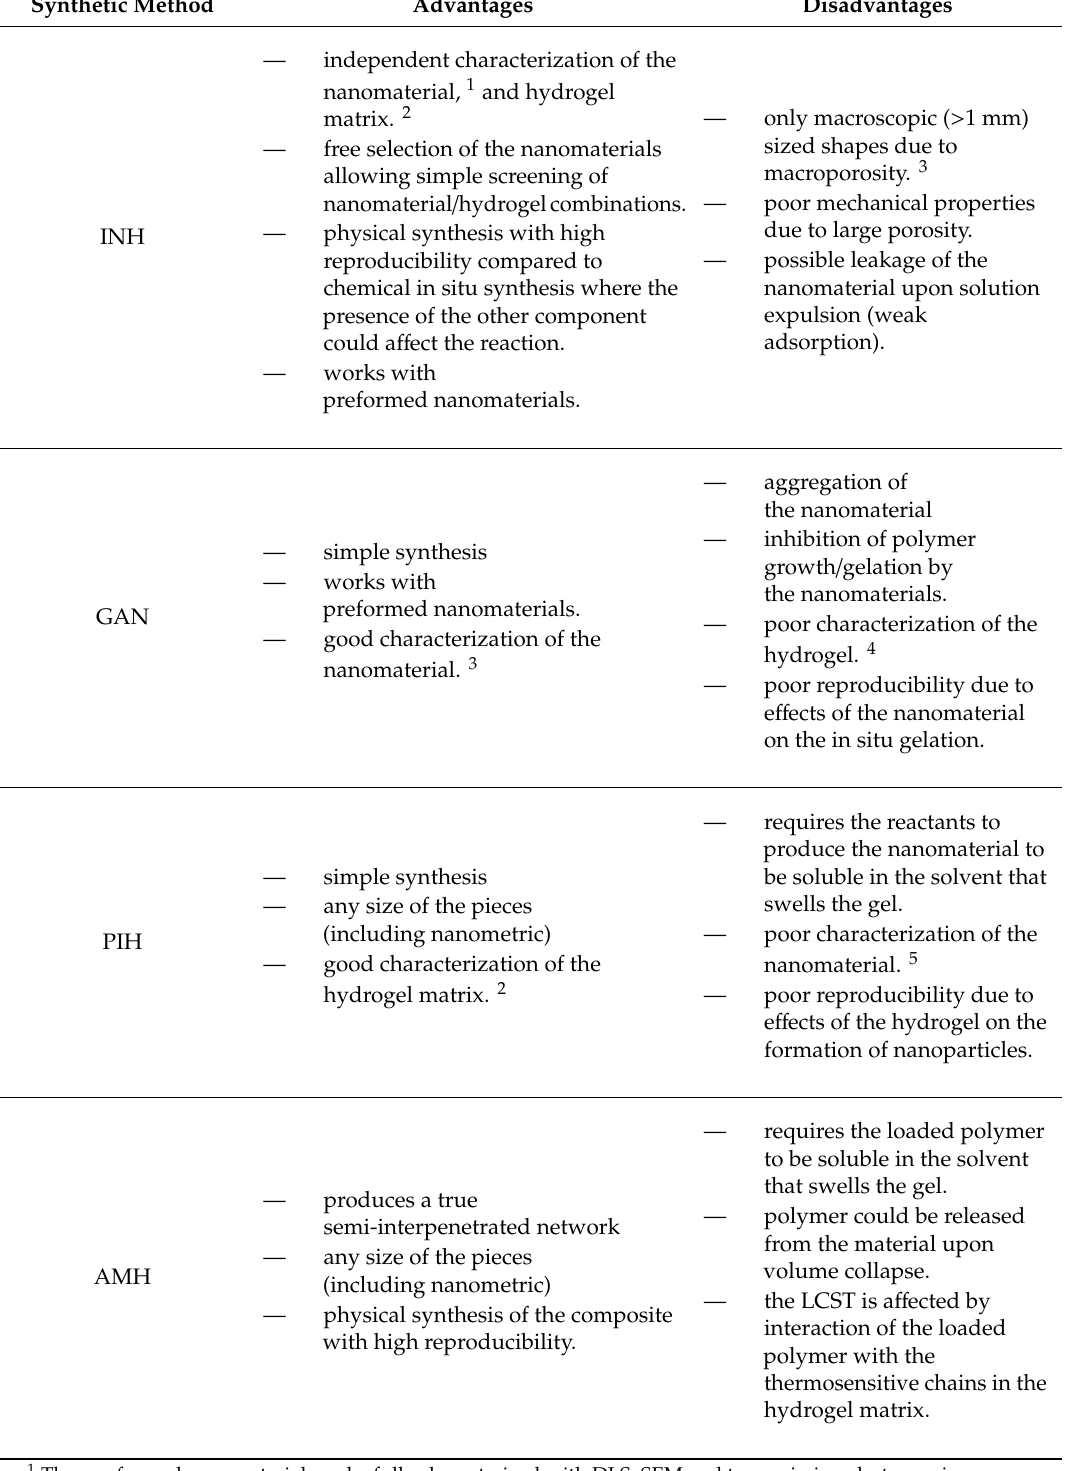
Table 2. Advantages and disadvantages of the di ff erent synthetic methods described before. Synthetic